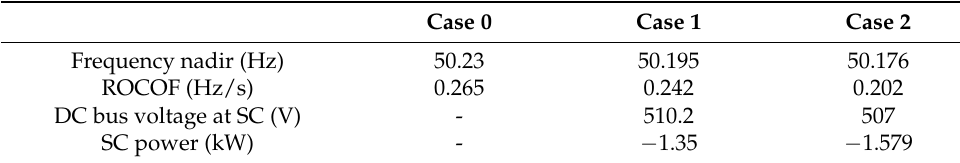
Figure 16. DC bus voltage at SC for over-frequency event. Table 6. Comparison table for the sudden load